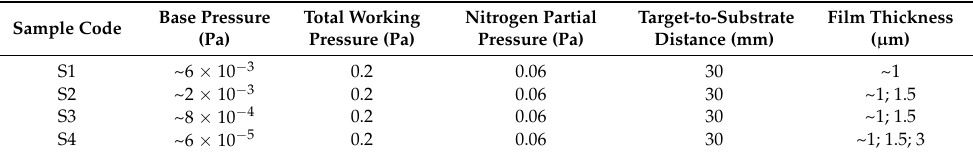
Table 1. Aluminum Nitride (AlN) thin films deposition